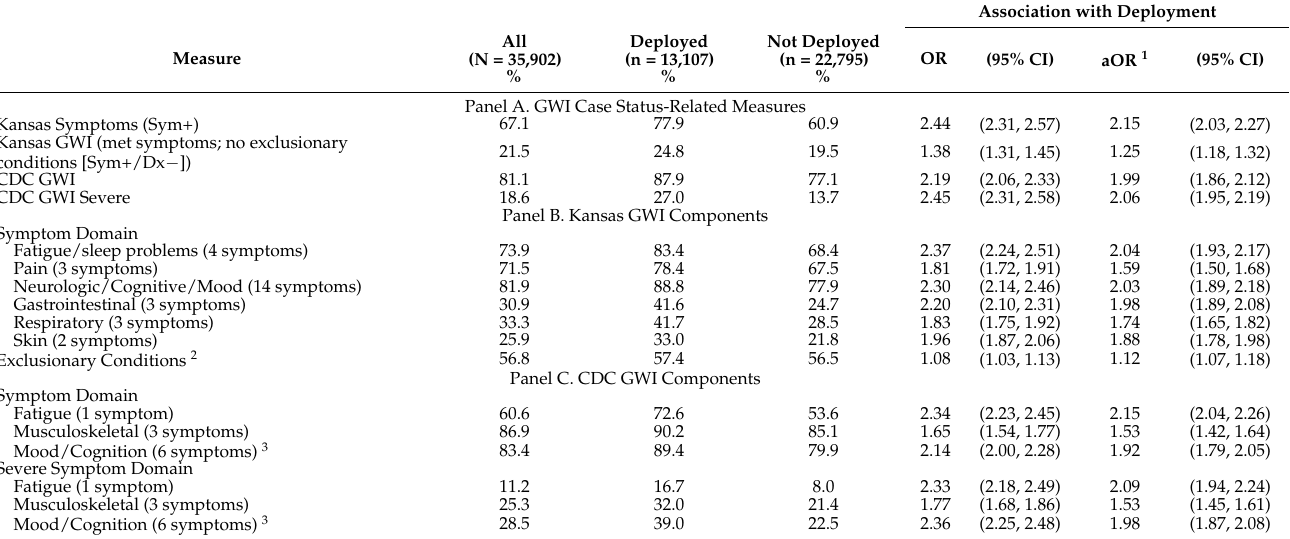
Table 2. Associations of Gulf War Illness Phenotypes with 1990–1991 Gulf War Deployment Status.